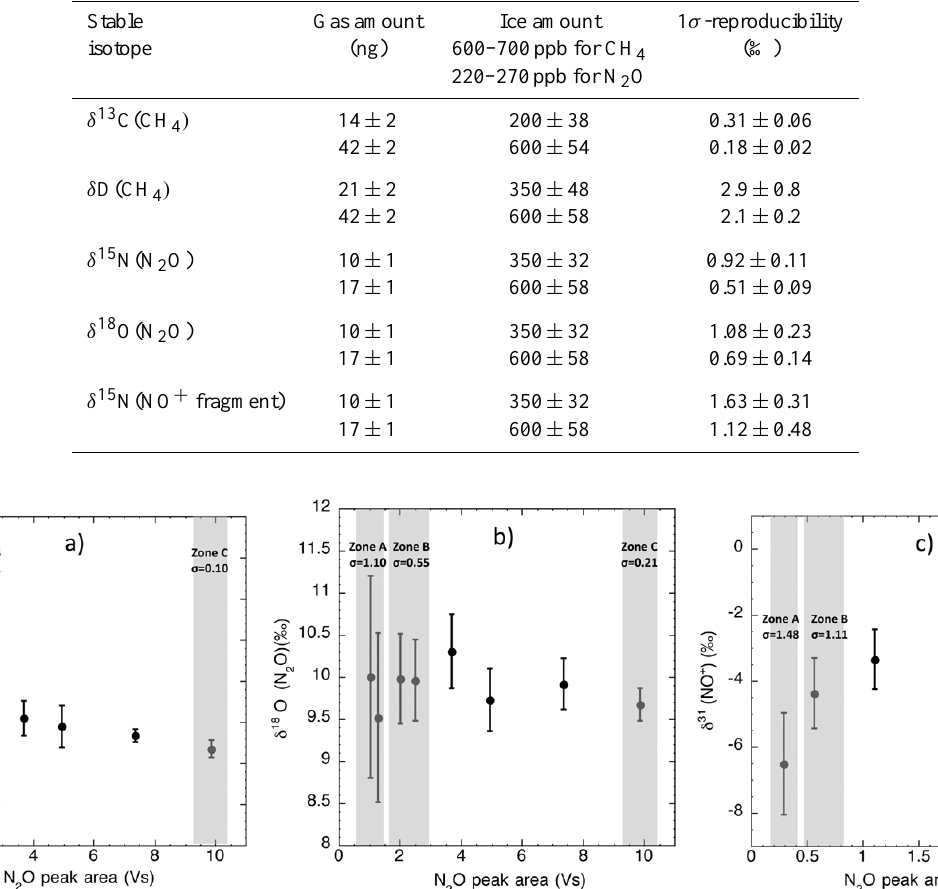
Table 2. System reproducibility. Five samples of similar ice were measured for each test. For each isotope signature, the first line gives the reproducibility for the minimum amount of ice necessary for reliable measurements and the second line gives the reproducibility for our preferred conditions, which is a trade-off between high precision and possible high temporal resolution.